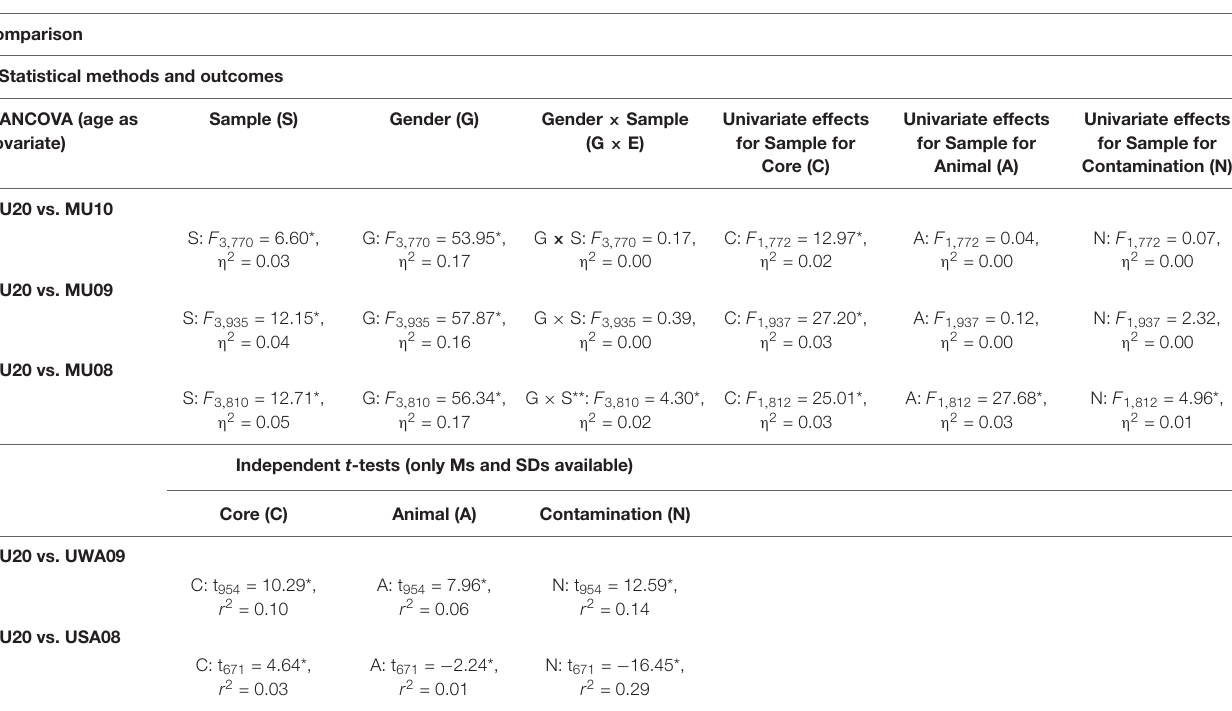
TABLE 5 | Comparison of the current sample with previous student samples for the Disgust